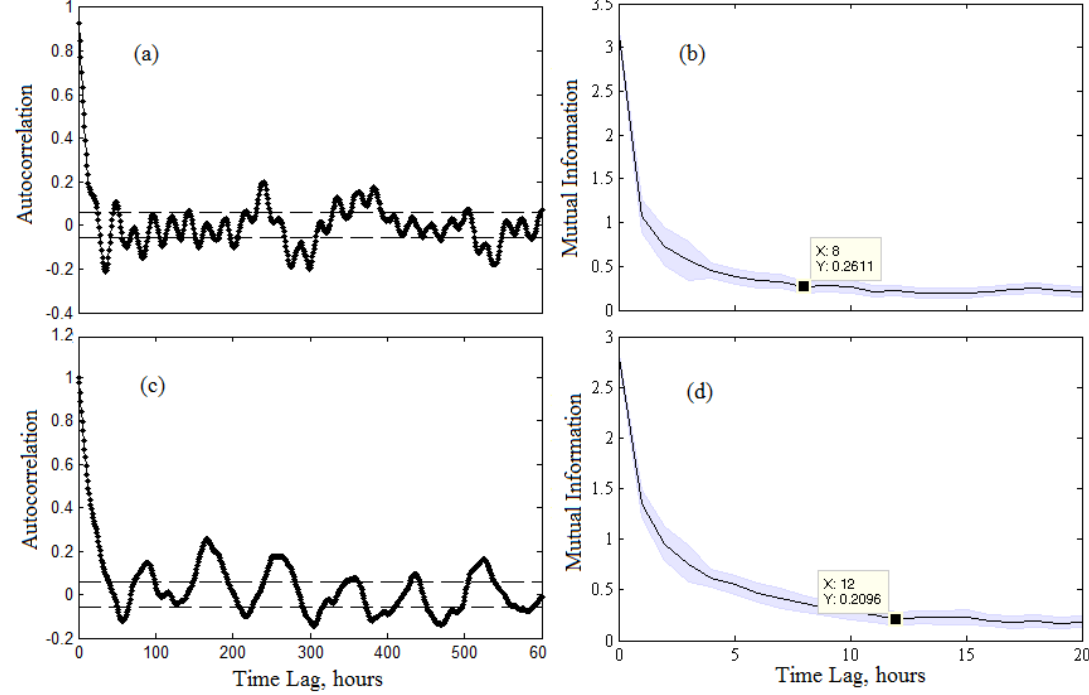
Figure 5. (a) and (b) Wind speed autocorrelation and average mutual information, (c) and (d) Wind power autocorrelation and average mutual information.